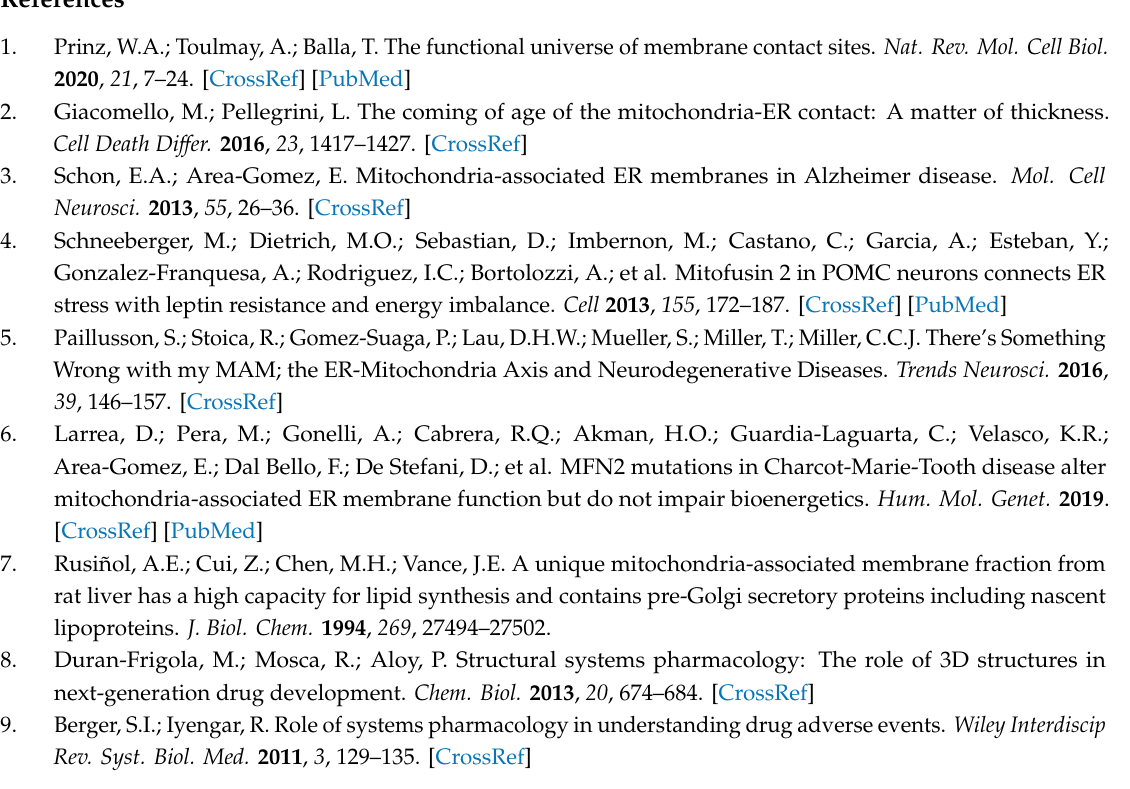
proteomic studies. We highlight proteins that are either tissue-specific or common among mitochondria-associated membranes isolated from di ff erent cell types or